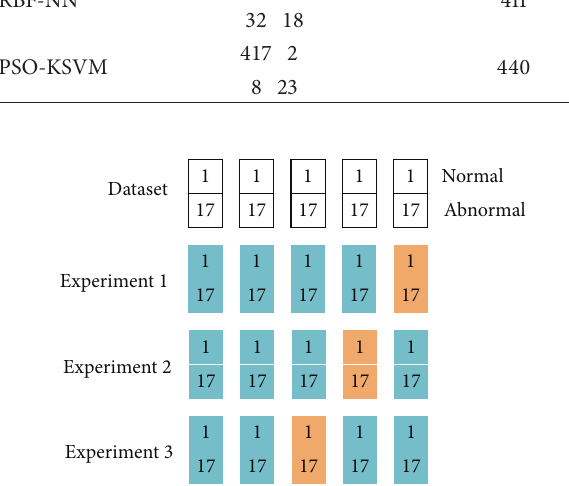
Figure8:Theproceduresof3-level2DDWT:(a)normalbrainMRI; (b) level 3 wavelet